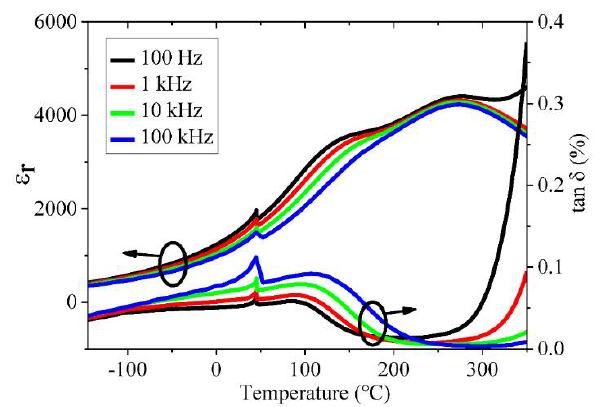
Figure 2. The temperature dependent dielectric constant and dielectric loss curves of poled <001> oriented NBT-6BT-KNN crystal measured at different frequencies.